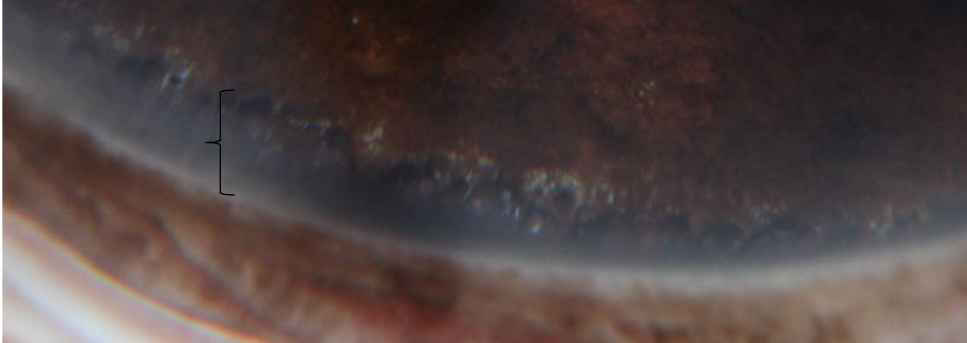
Figure 2. The pectinate ligament visualized by gonioscopy (accolade ‘{‘) (AE